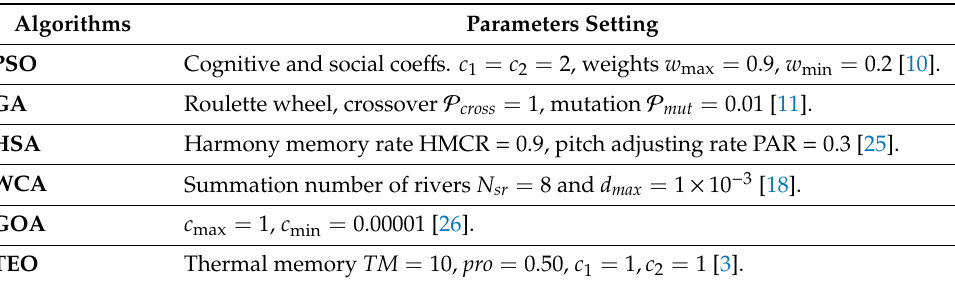
Table 2. Parameter setting of reported